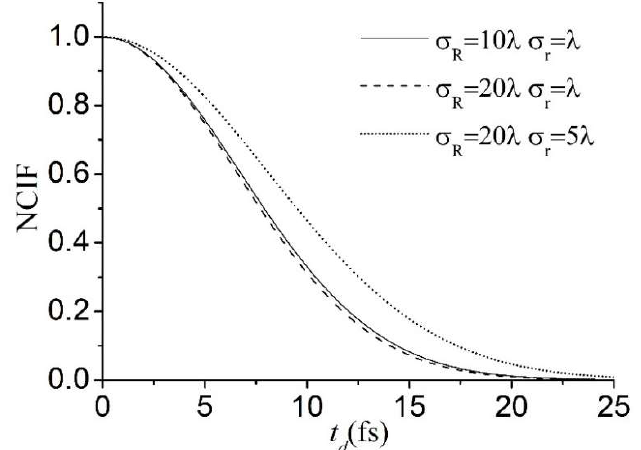
Figure 5. The NCIF of the scattered partially coherent Gaussian Schell-model plane-wave pulse versus t d = t 2 − t 1 for different values of σ R and σ r of the quasi-homogeneous random medium with θ = 0.5 .